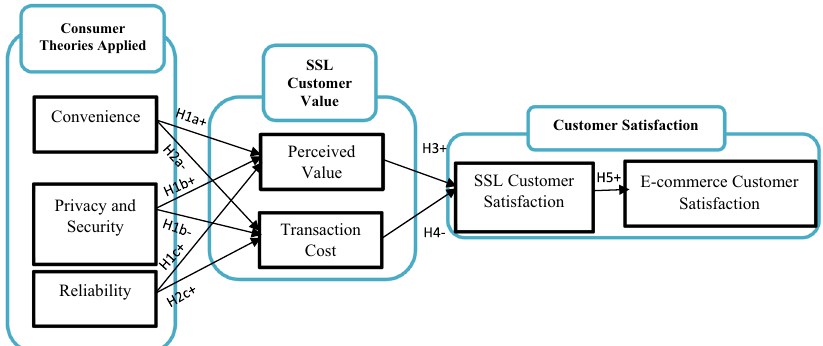
Fig. 1 Conceptual framework